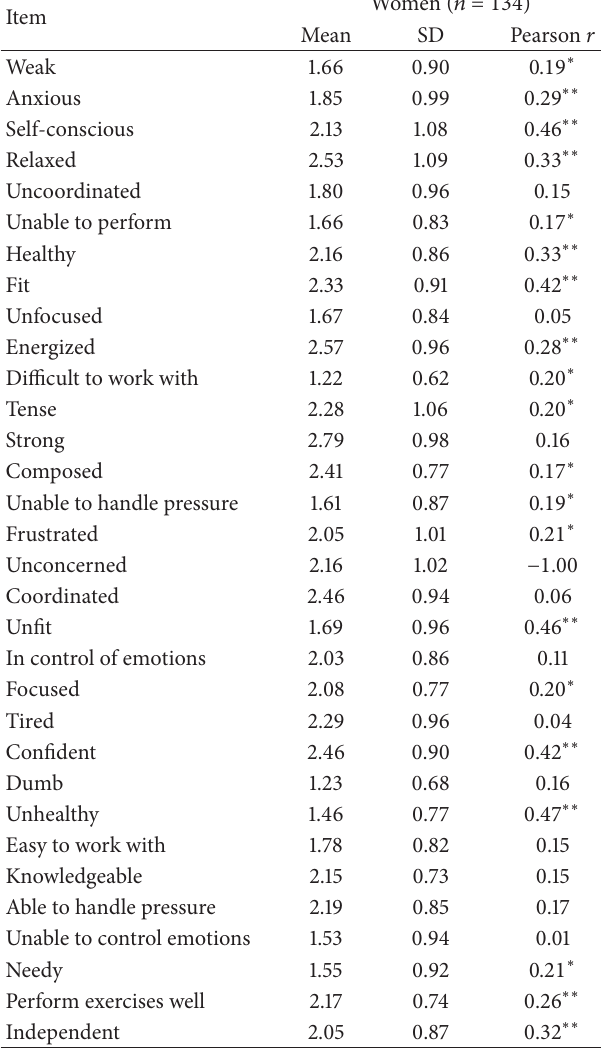
Table 2: Ratings for SPIRQ items and correlation with SPA for female Women (𝑛 = 134) Median (range)